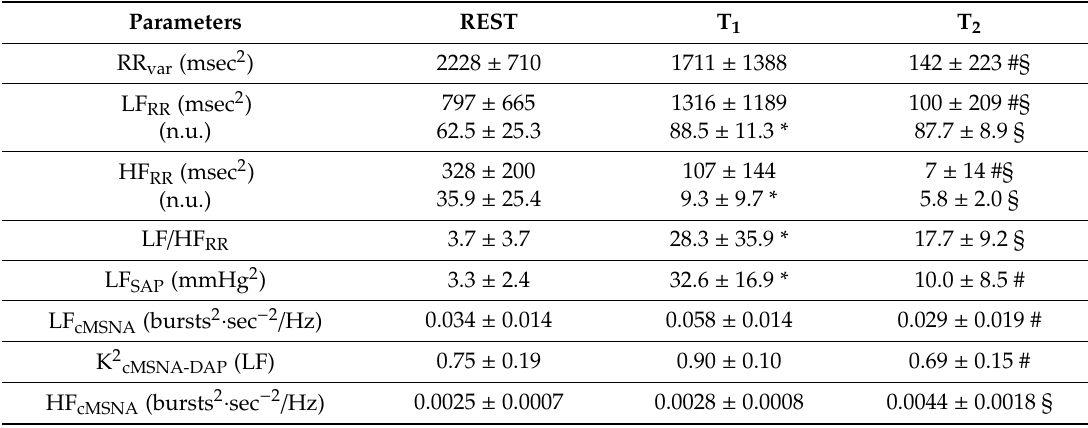
Table 3. Spectral parameters of autonomic function while supine (REST), during the asymptomatic phase of tilt (T 1 ) and the period of tilt just preceding syncope (T 2 ). Values are expressed as mean ± standard